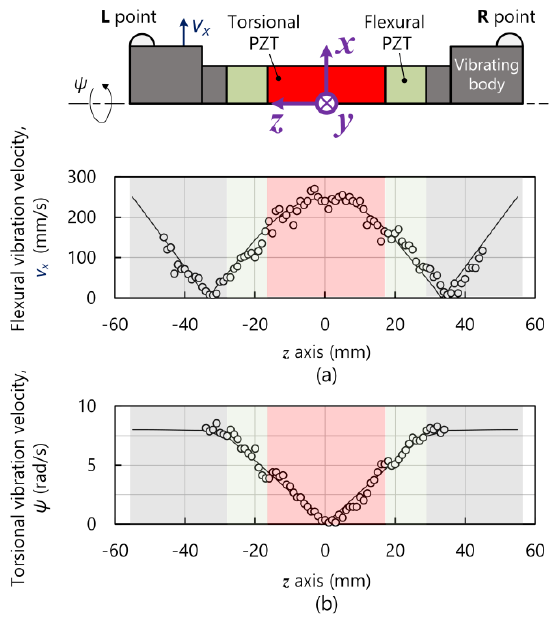
Figure 6. ( a ) Flexural and ( b ) torsional vibration velocity distributions in the z axis. The dots and curves indicate the measured and simulated results, respectively.